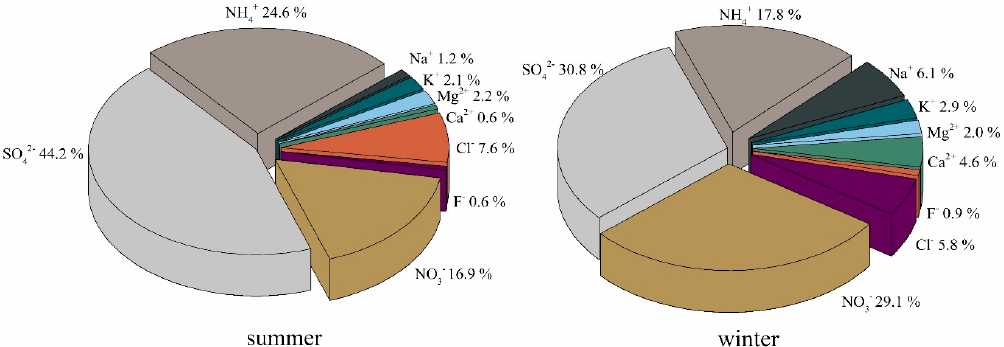
Figure 3. Relative percentages of ionic species in PM 2.5.